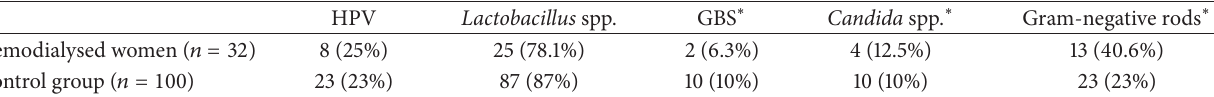
Table 4: Frequency of selected microorganisms in the group of hemodialysed women and controls (the number and percentage of positive cases). HPV Gram-negative rods